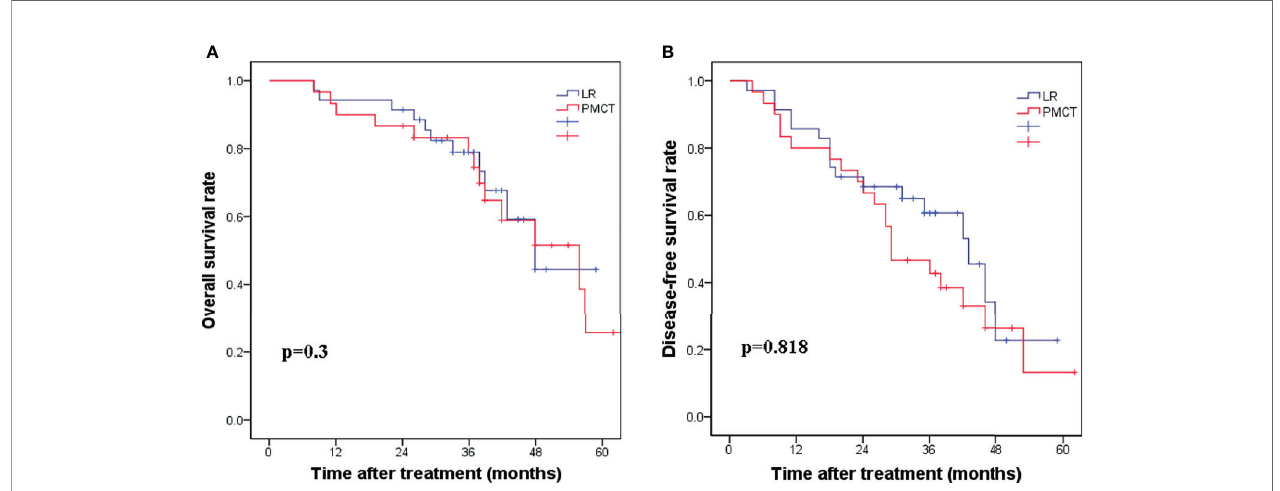
FIGURE 2 | (A) The corresponding 1-, 3-, and 5-year disease-free survival rates in the LR group compared with the PMCT group. ( p = 0.818). (B) The corresponding 1- , 3-, and 5-year overall survival rates in the LR group compared with the PMCT group. ( p = 0.3). LR, liver resection; PMCT, percutaneous microwave coagulation